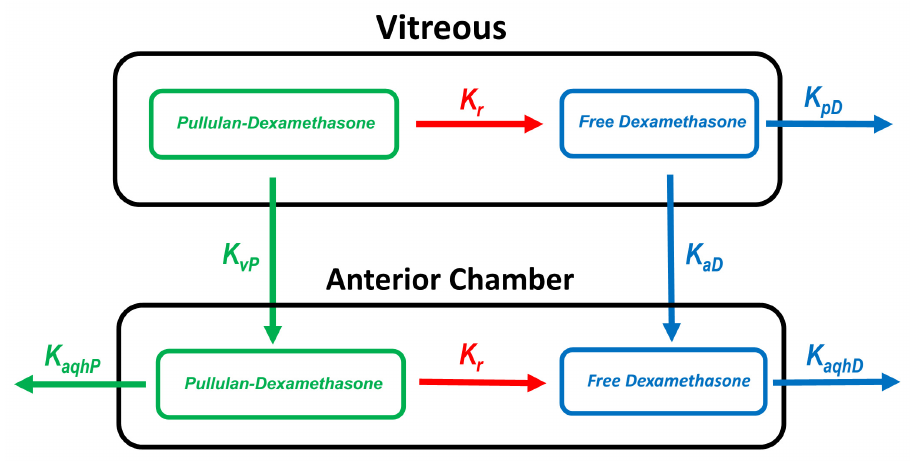
Figure 2. Scheme of the kinetic simulation model. The following parameters were used: K r (first- order release rate constant); K pD (elimination rate constant of free dexamethasone posteriorly from the vitreous); K aD (distribution rate constant of free dexamethasone from the vitreous to the anterior chamber); K vP (distribution rate constant of pullulan–dexamethasone from the vitreous to the anterior chamber); K aqhP (elimination rate constant of pullulan–dexamethasone from the anterior chamber) and K aqhD (elimination constant of dexamethasone from the anterior chamber). For detailed parameter values, see Supporting Information SI-4.